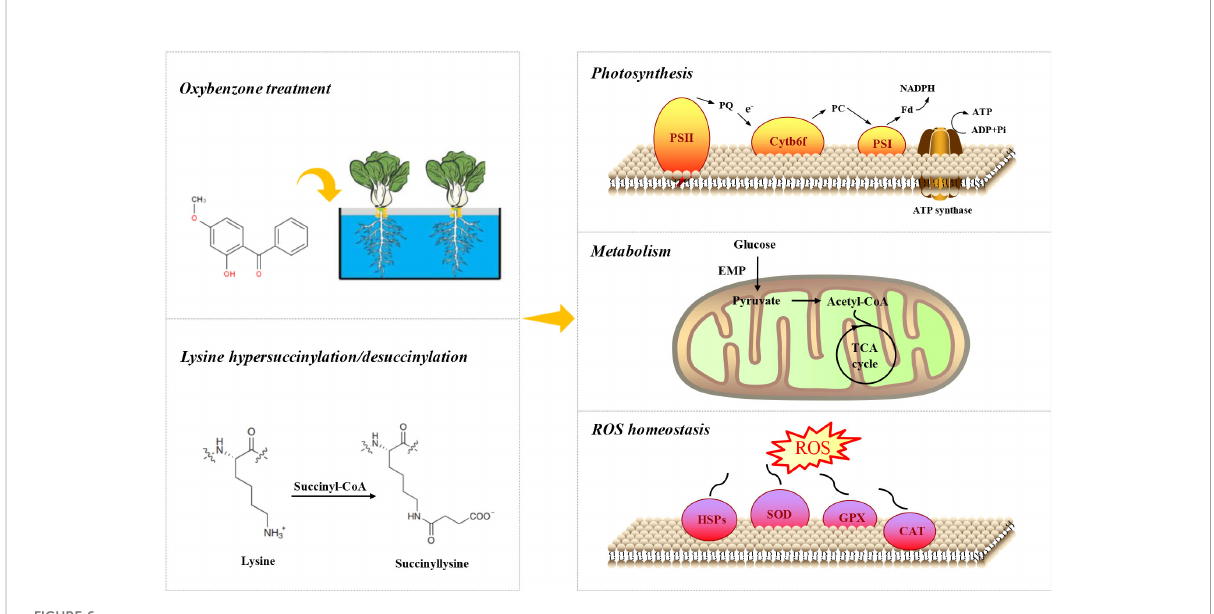
FIGURE 6 Simpli fi ed map in pakchoi response to OBZ